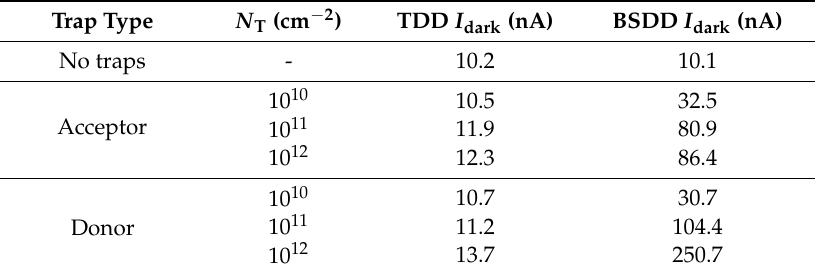
Table 2. Impact of the interface traps on the anode dark current for the BSDD and TDD structures described in Table 2. Total oxide areas of the BSDD and TDD structures are 0.19 cm 2 and 0.0005 cm 2 ,